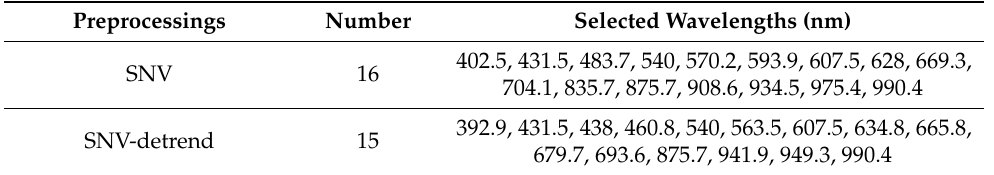
Figure 10. Selection of characteristic wavelengths using SPA after SNV-detrend preprocessing: ( a ) number of effective variables and ( b ) visualized characteristic wavelengths in the raw spectra. Table 5. The characteristic wavelengths selected by SPA.